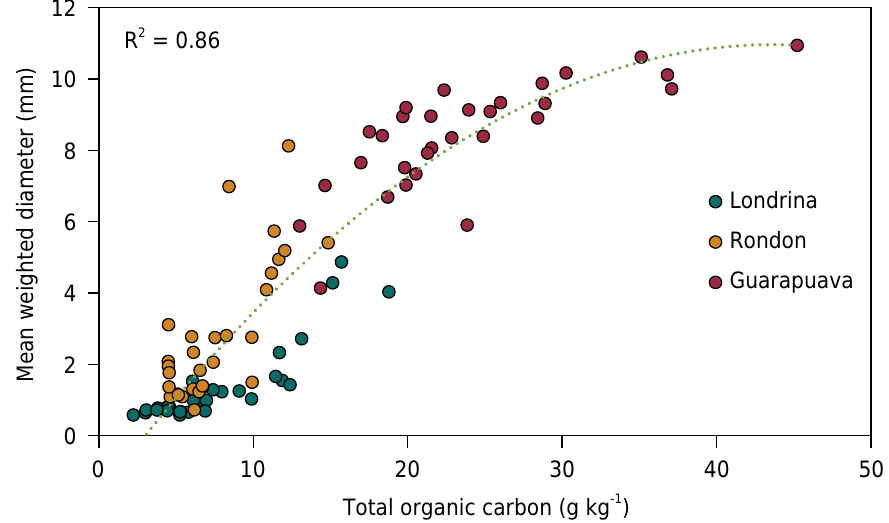
Figure 4. Mean weighted diameter of water-stable aggregates as a function of total organic